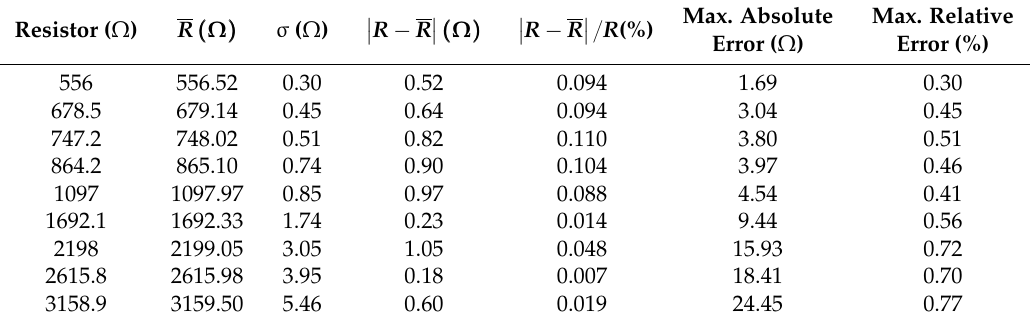
Table 4. Accuracy data for R ij estimation by using Equation (44) R P r 556 Ω ,3159 Ω s